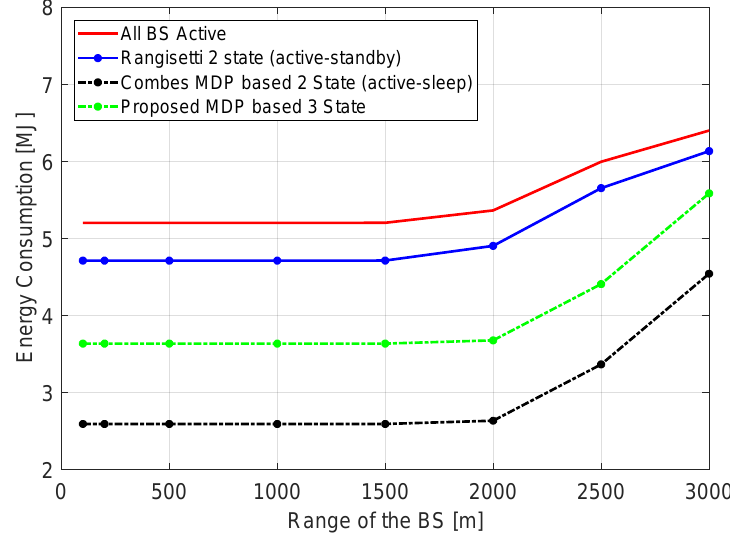
Figure 8. Effect of varying the range of the